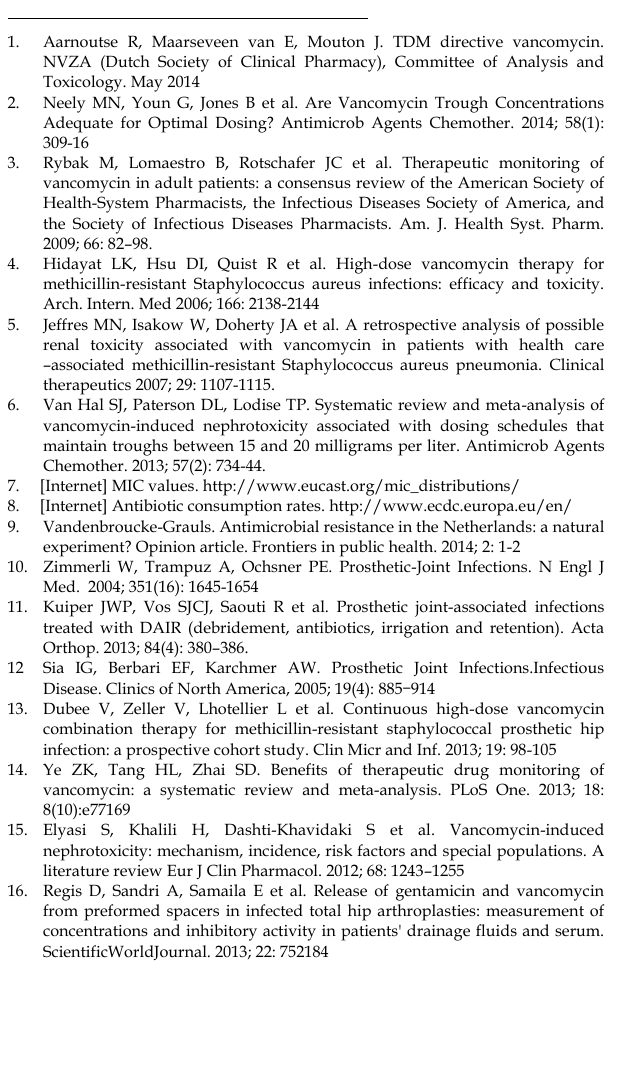
1-stage revision 7(70)